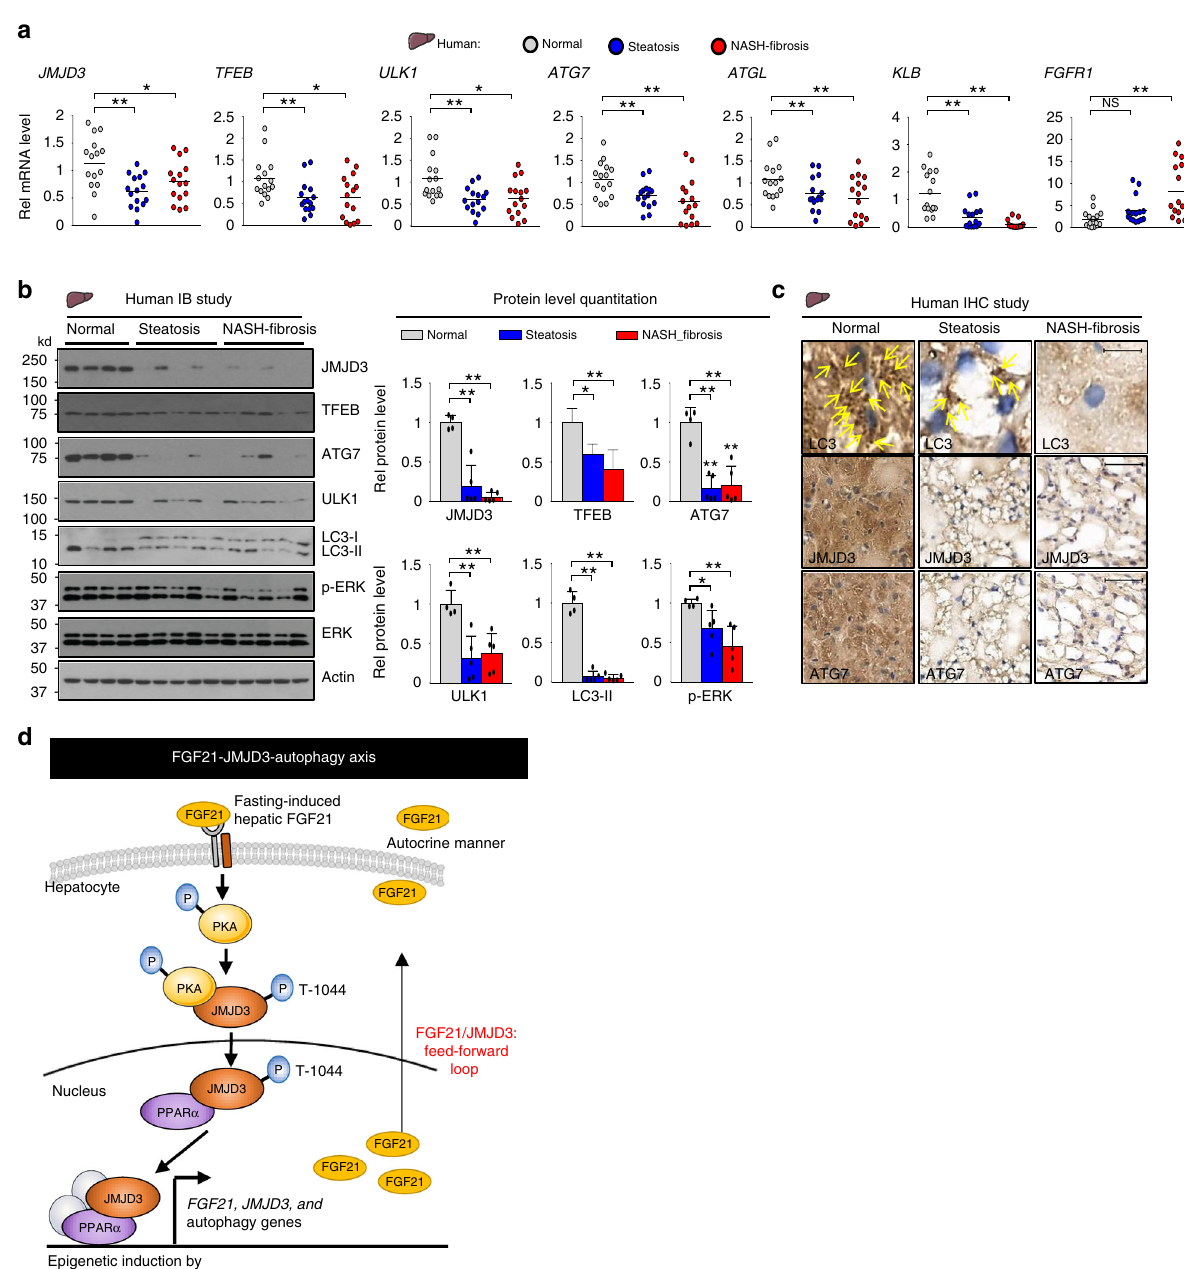
Fig. 9 Expression of JMJD3, TFEB , and autophagy genes is reduced in NAFLD patients. Liver samples from normal, simple steatosis and NASH- fi brosis patients were analyzed. a The mRNA levels of the indicated genes measured by q-RTPCR ( n = 15 individuals). b Levels of the indicated proteins in liver samples detected by IB (left, n = 4 normal, n = 5 patients, 3 to 4 pooled samples/lane) and quanti fi ed (right). c LC3, JMJD3, and ATG7 were detected in liver sections by IHC. LC3 puncta are indicated by yellow arrows (scale bar = 10 μ m for LC3, 50 μ m for JMJD3 and ATG7). Source data are provided as a Source Data fi le. a , b Values are presented as mean ± SD. Statistical signi fi cance was measured using the a , b one-way ANOVA with the Bonferroni post- test. * P < 0.05, ** P < 0.01, and NS statistically not signi fi cant. d Model: in response to fasting, JMJD3 is phosphorylated at Thr-1044 by FGF21 signaling- activated PKA in mouse hepatocytes, which promotes its nuclear localization and interaction with the nuclear receptor PPAR α to epigenetically induce transcription of genes involved in autophagy and lipid degradation, including Atg7, Ulk1, Atgl, Tfeb, and Pgc-1 α , and as a positive feed-forward loop, JMJD3 and FGF21 expression. Induced hepatic FGF21 sustains the activation of the FGF21-JMJD3-autophagy axis in an autocrine manner when fasting